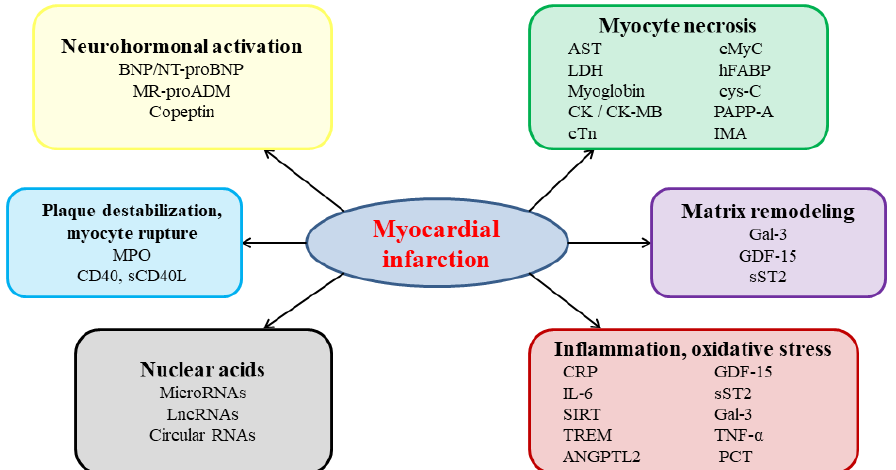
Figure 2 . Pathophysiological pathways in acute myocardial infarction and examples of associated candidate